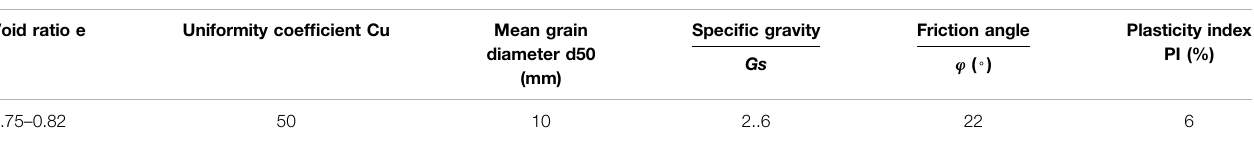
TABLE 1 | The mechanical parameters of the dam soil.